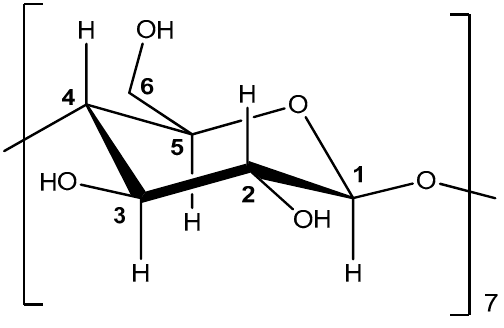
Figure 3. Structure of β -CD showing the numbering of β -glucose monomer.